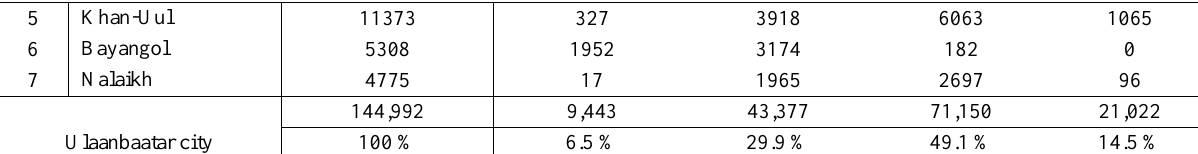
Table 3. The total number of pit latrines in districts.